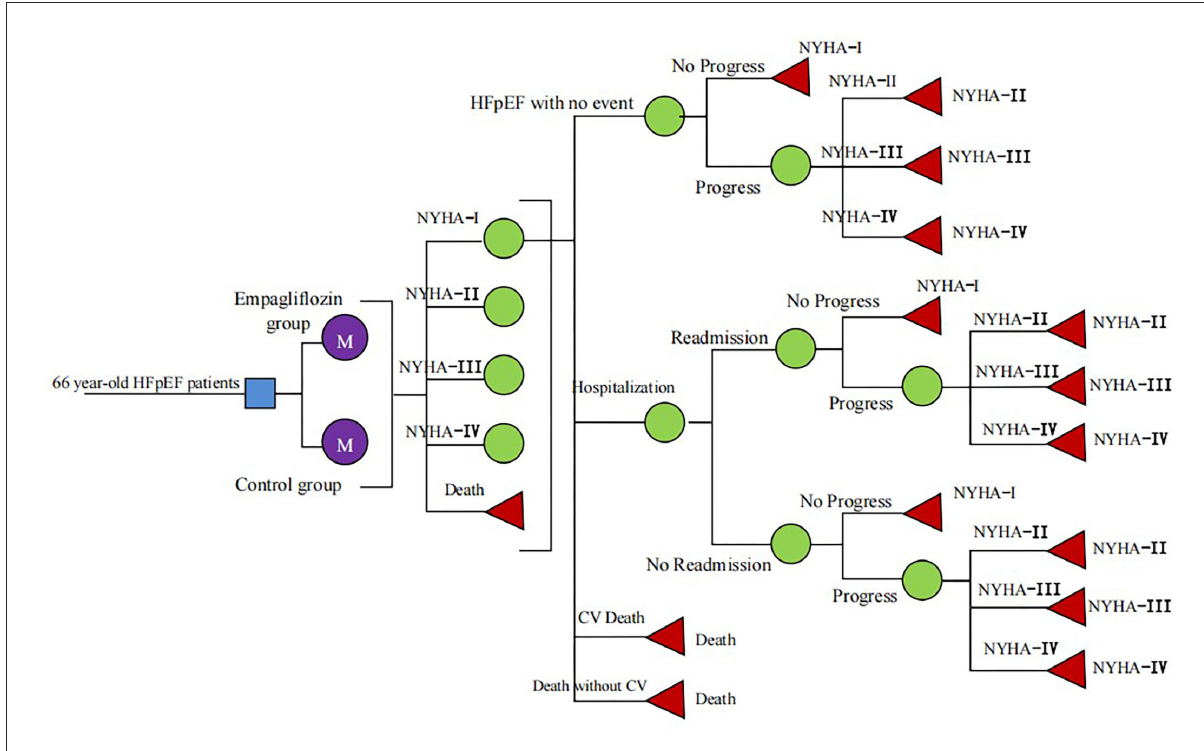
FIGURE1 Schematic representation of the Markov